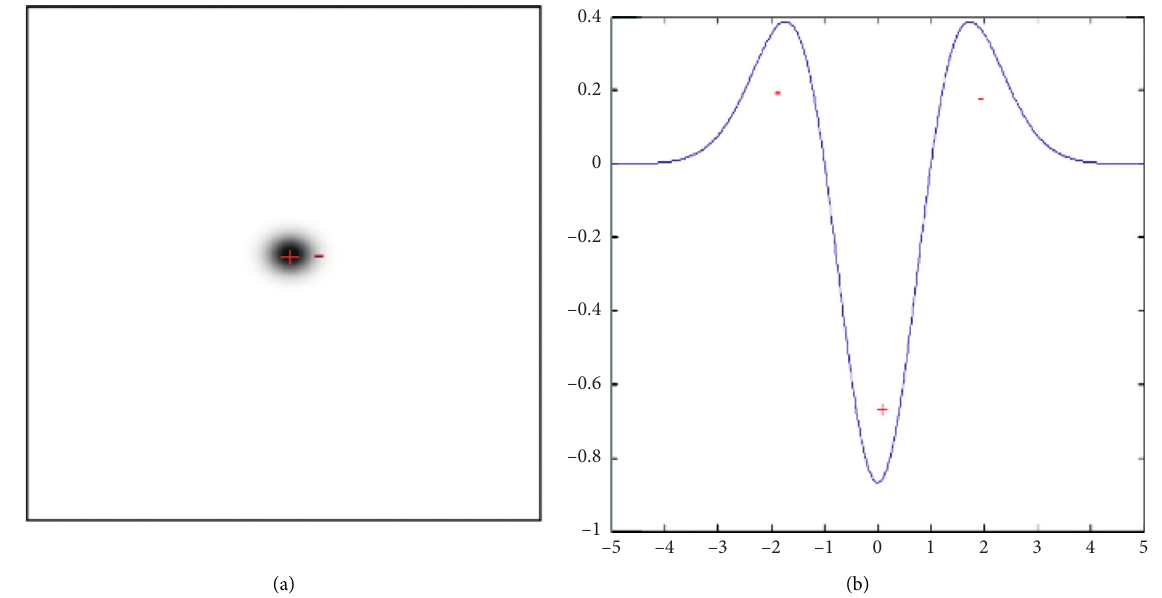
Figure 6: (a) Spot-like target. (b) One-dimensional Laplacian of Gaussian